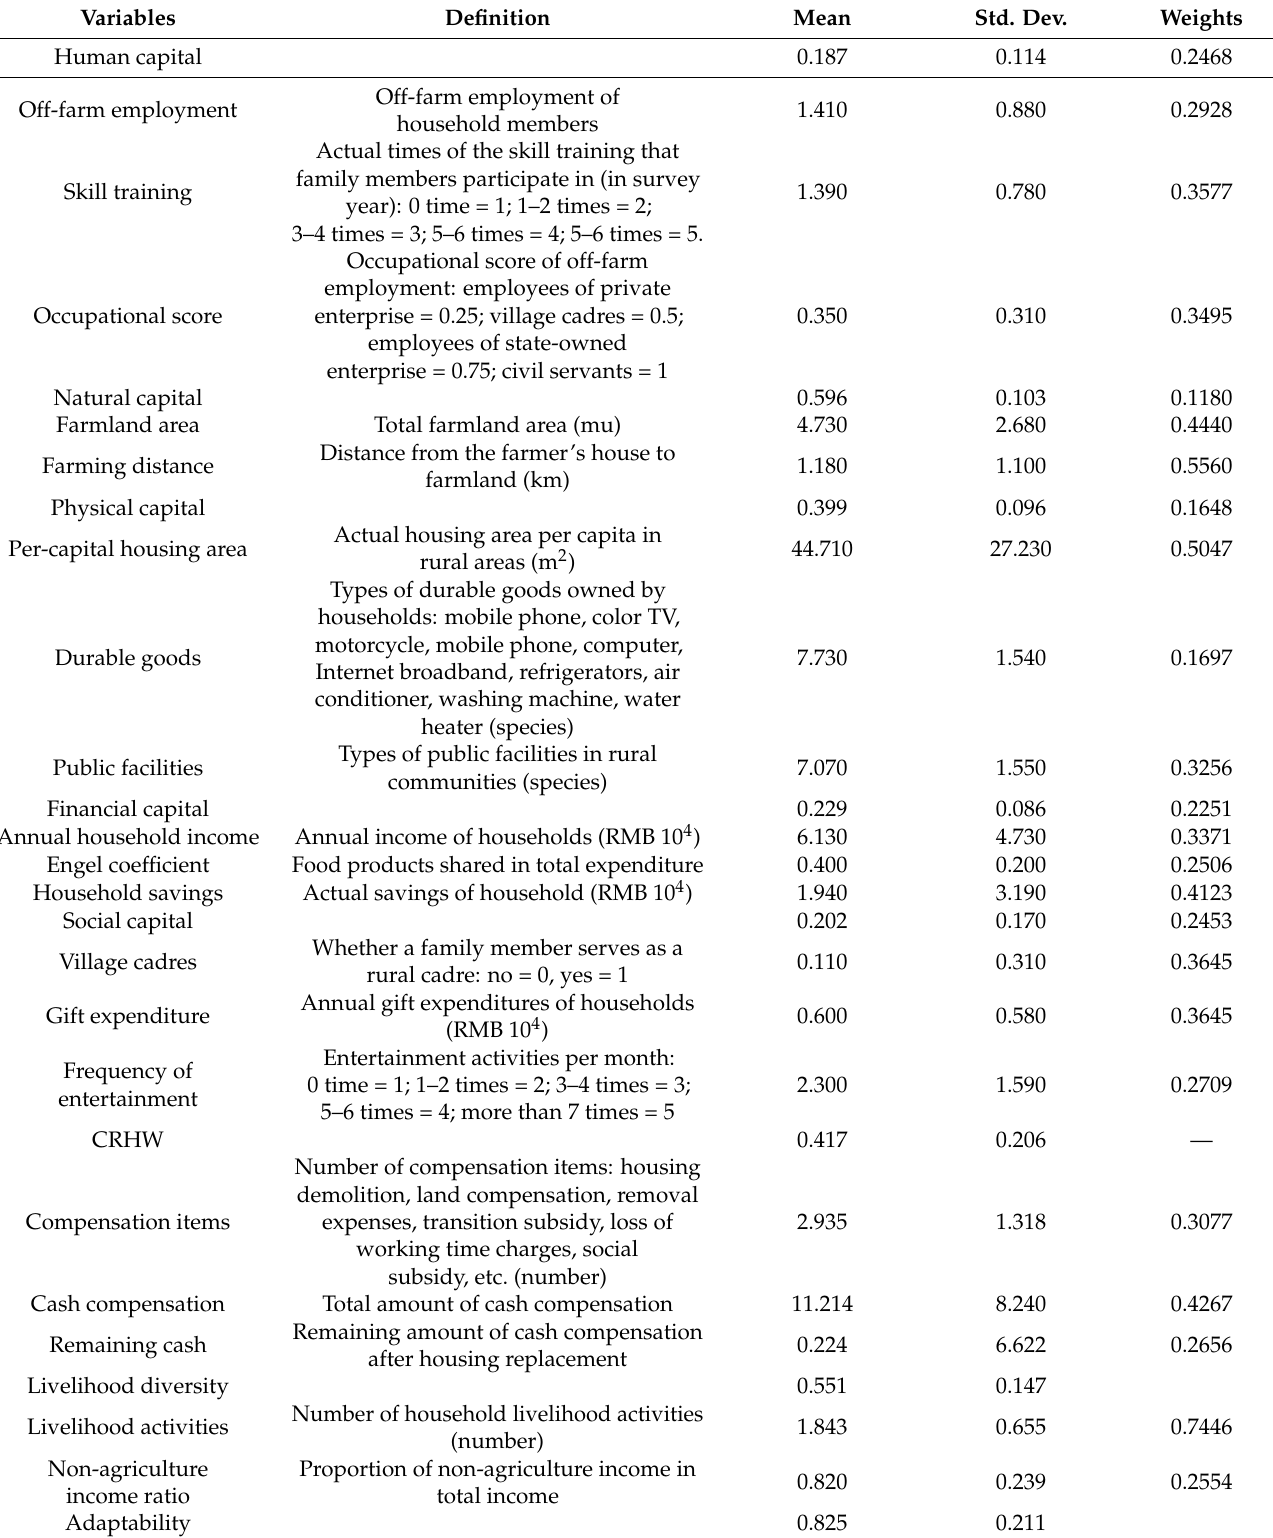
Table 1. Definition, descriptive statistical analysis, and weight of each